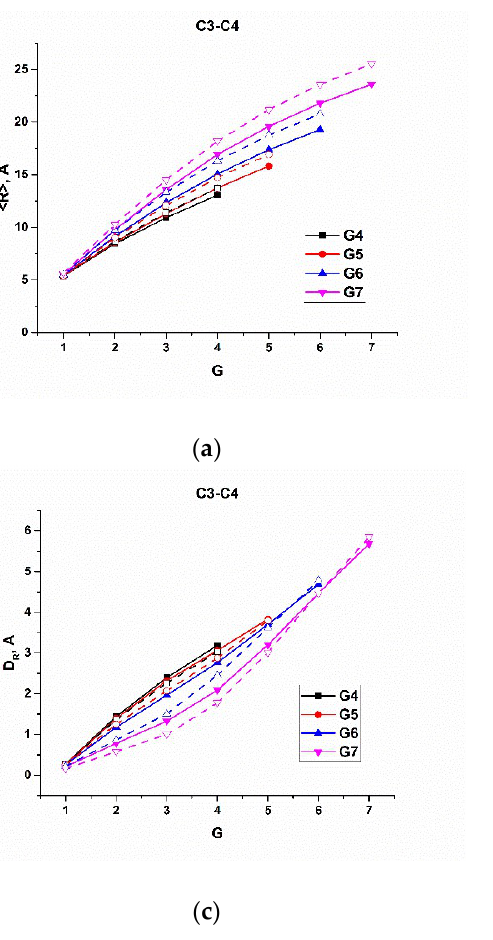
Figure 7. ( a ) The average distance, <R>, of the Si branching atoms to the core atom, ( b ) the average angle, <Ω>, between the Si atom and the center of mass of the dendron ( c ) the square root of the R dispersion, D R , and ( d ) the square root of the Ω dispersion, D Ω , calculated for c3-dendrimers (solid lines) and for c4-dendrimers (dashed lines).